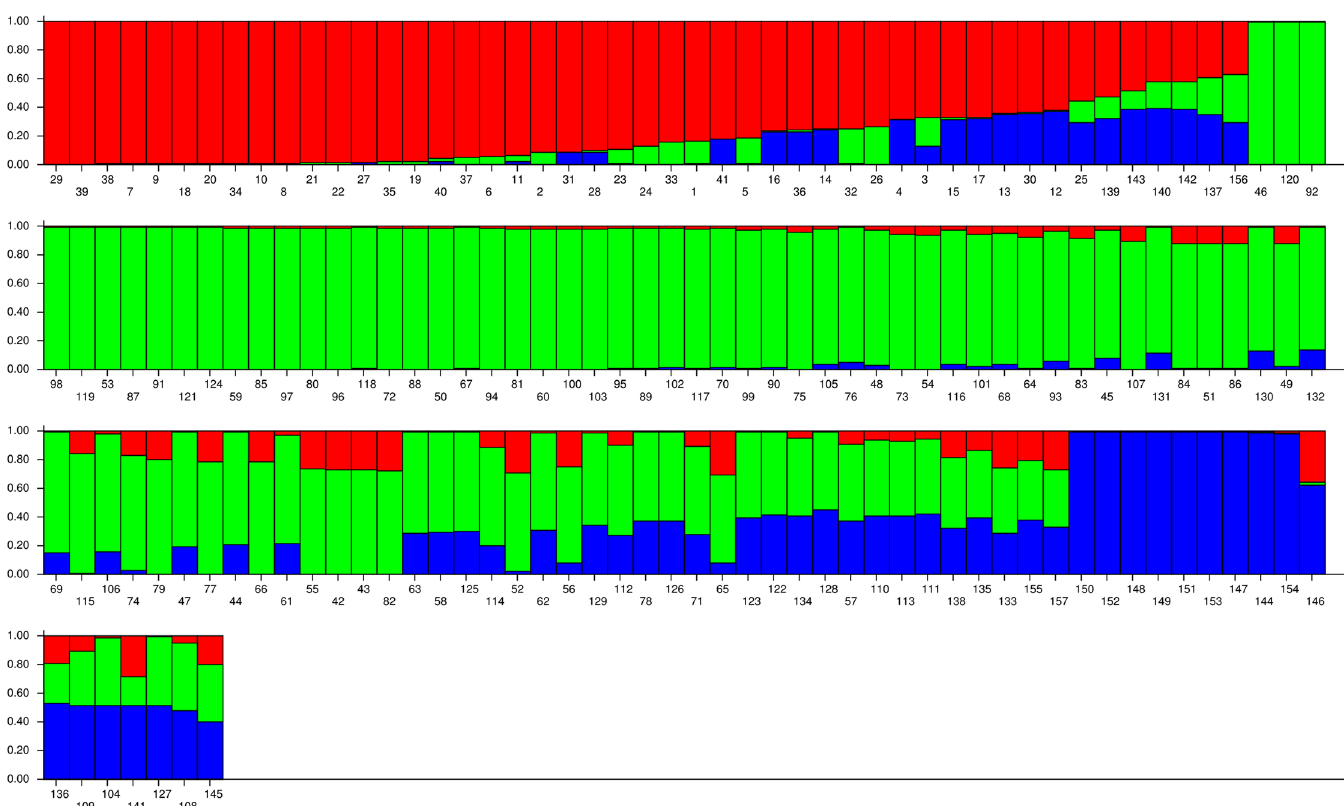
Fig 2. Population structure of 157 bermudagrass accessions based on sequence-related amplified polymorphism (SRAP) markersfor K = 3. Each color represents one subgroup (subgroupC1 = red; C2 = green; C3 = blue) and the length of the colored segment shows the estimated membership proportionof each sample to designed